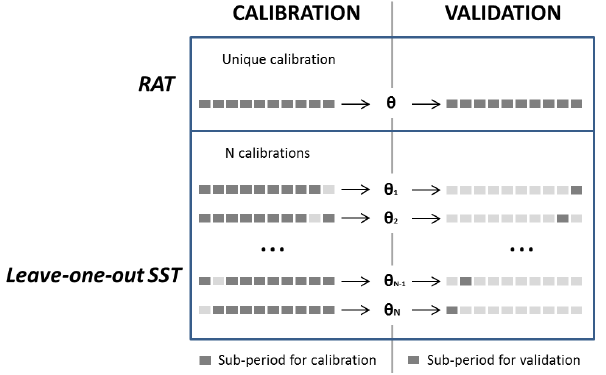
Figure A1. Comparison of the RAT procedure with a leave-one-out split-sample test (SST). Both methods have N validation periods (one per year). The RAT needs only one calibration, whereas the SST requires N calibrations. Dark grey squares represent the years used for calibration or validation.